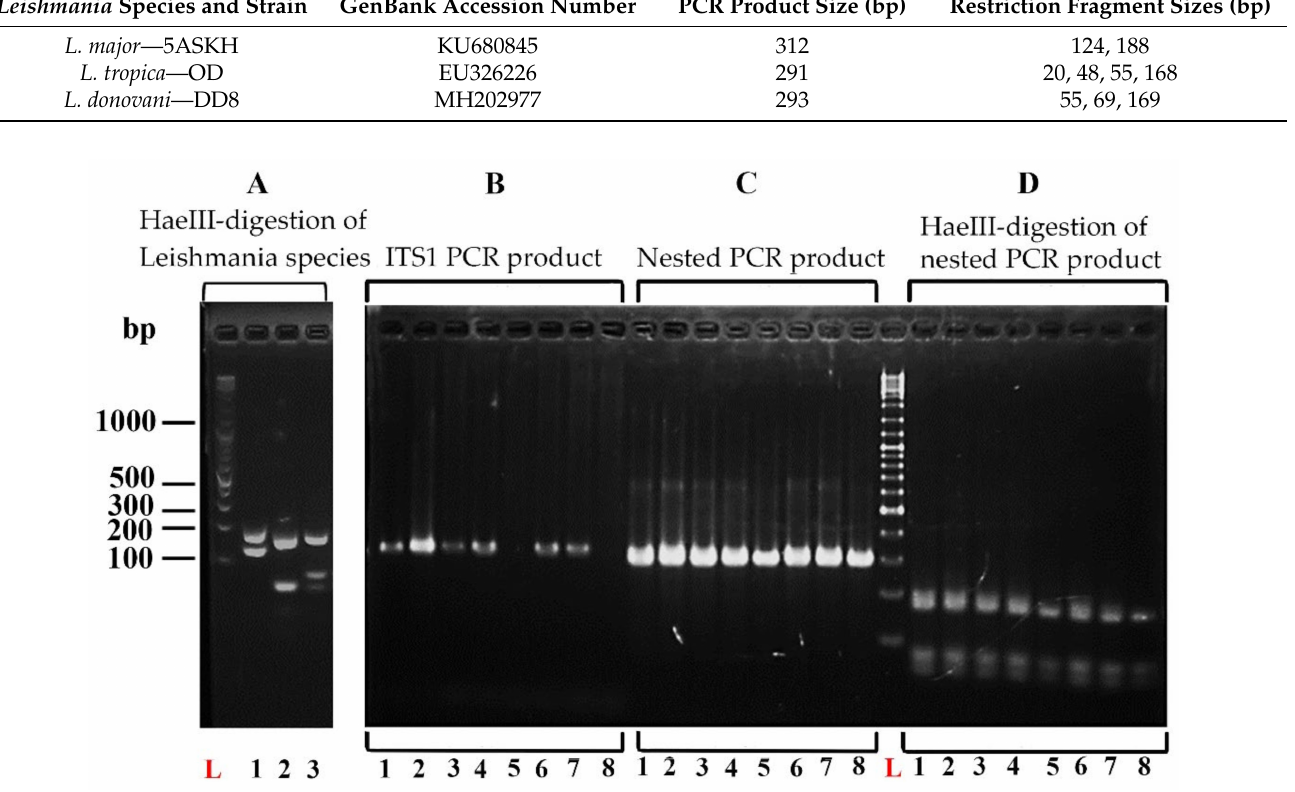
Figure 3. ( A ) RFLP patterns of reference strains (L: 100 bp DNA ladder, lane 1: L. major , 2: L. tropica